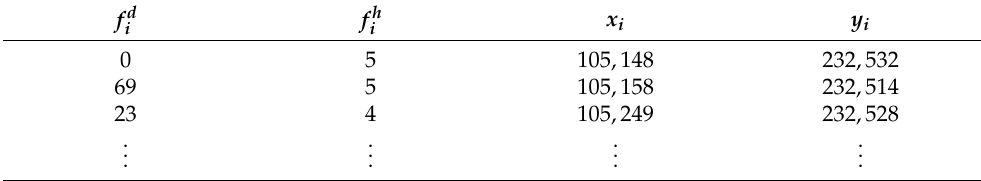
Table 1. Forest density and fire hazard